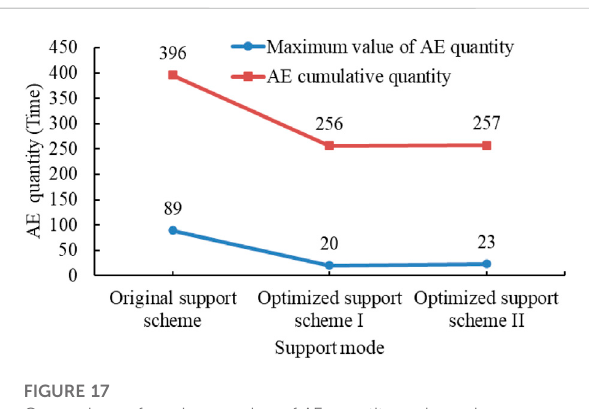
FIGURE 17 Comparison of maximum value of AE quantity under various support